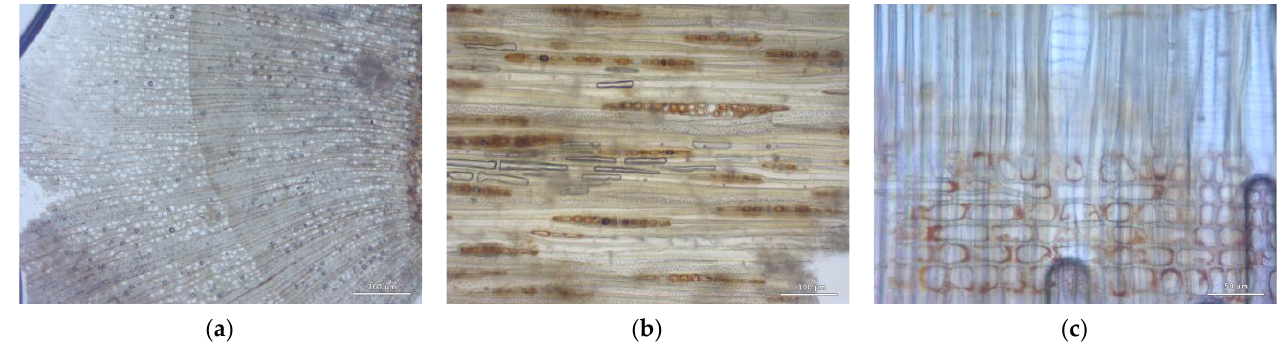
Figure 4. Characteristic sections identified as belonging to the Corylus genus: ( a ) Cross-section of sample AS3; ( b ) Tangential section of sample CA1; ( c ) Radial section of sample